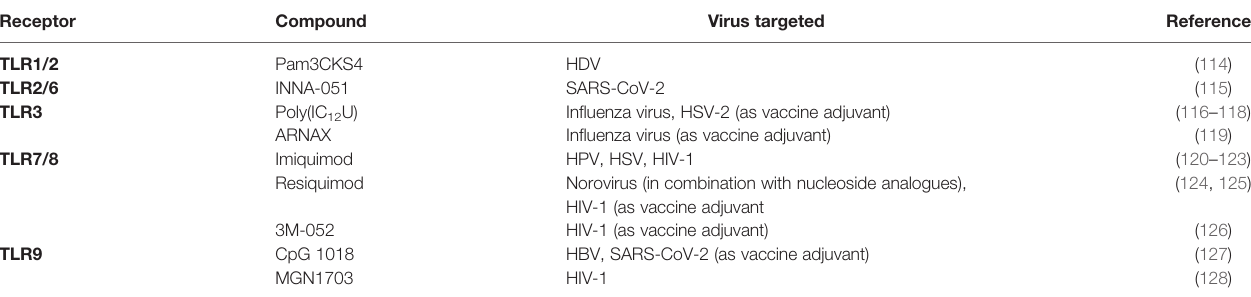
TABLE 2 | TLR agonists under study against viral